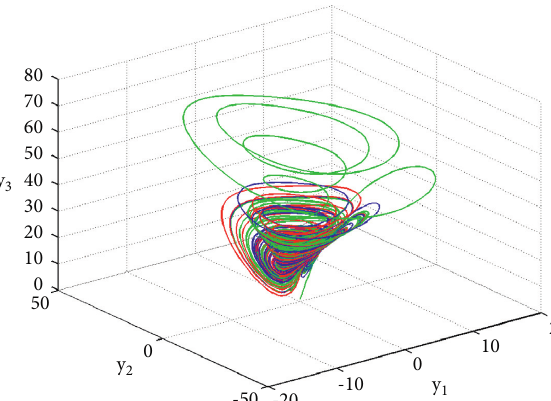
Figure 3: 3D plot of a self-excited chaotic attractor in the integer-order Matouk’s system using the parameter set A ( 0 . 1 , 0 , 1 , 0 . 01 ) for green trajectory, ( 3 , 1 , 15 , 0 . 0199 ) for red trajectory, and (− 3 , − 1 , 15 , 0 . 0199 ) for blue